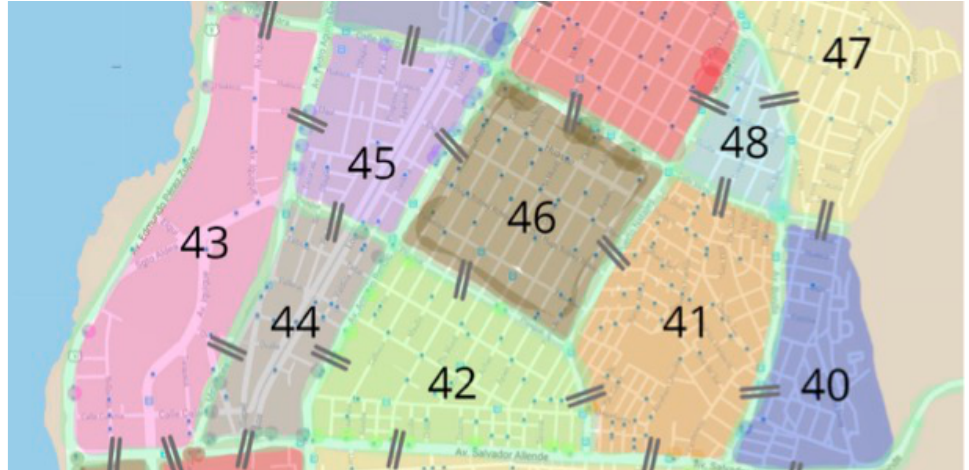
Figure 1. Divisions created in a zone of the city studied in the case study. The different groupings are shown in different colors, while the roads used to delimit the territories are highlighted in green. Additionally, the adjacency among basic units are shown through the inclusion of two lines between adjacent